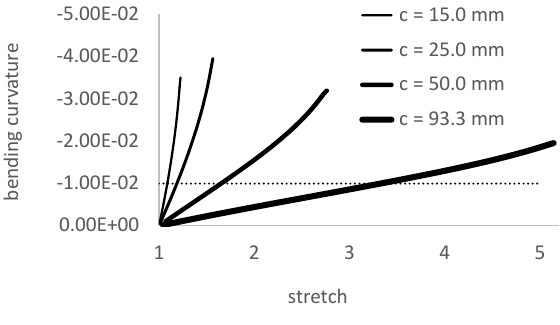
Figure 11: Bending curvatures versus corrugation amplitude, t = 1 mm